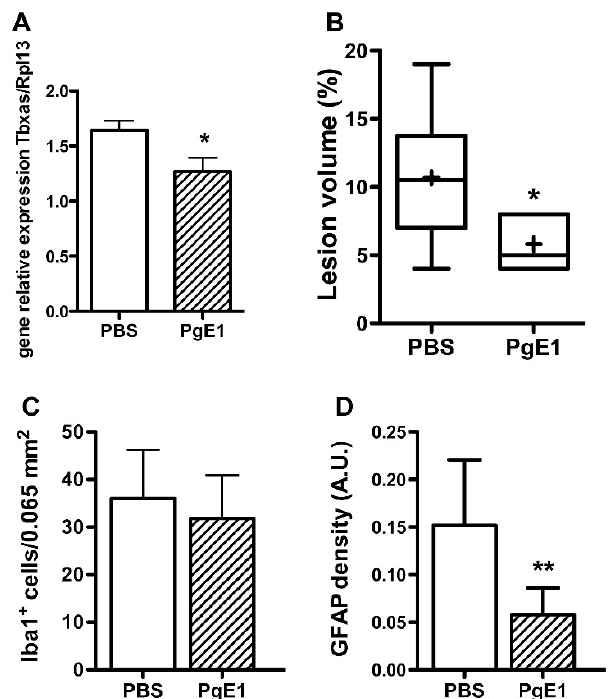
Figure 3. PgE1 induces better outcomes in neonatal ischemia at 48 h after ischemia-reperfusion. ( A ) Thromboxane A synthase-1 gene expression 2 h after ischemia-reperfusion in PBS- and PgE1-treated animals ( n = 6 per group). ( B ) Infarct volumes in PBS- ( n = 6) and PgE1-treated ( n = 6) animals. The + indicates the mean. ( C ) Number of microglial cells and ( D ) GFAP density (astrocyte density) in the penumbra ( n = 6 per group). * p < 0.05 vs. PBS; ** p < 0.01 vs. PBS.